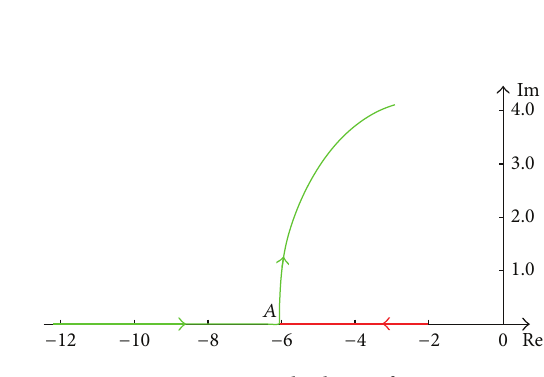
Figure 11: Eigenvalue locus of Case